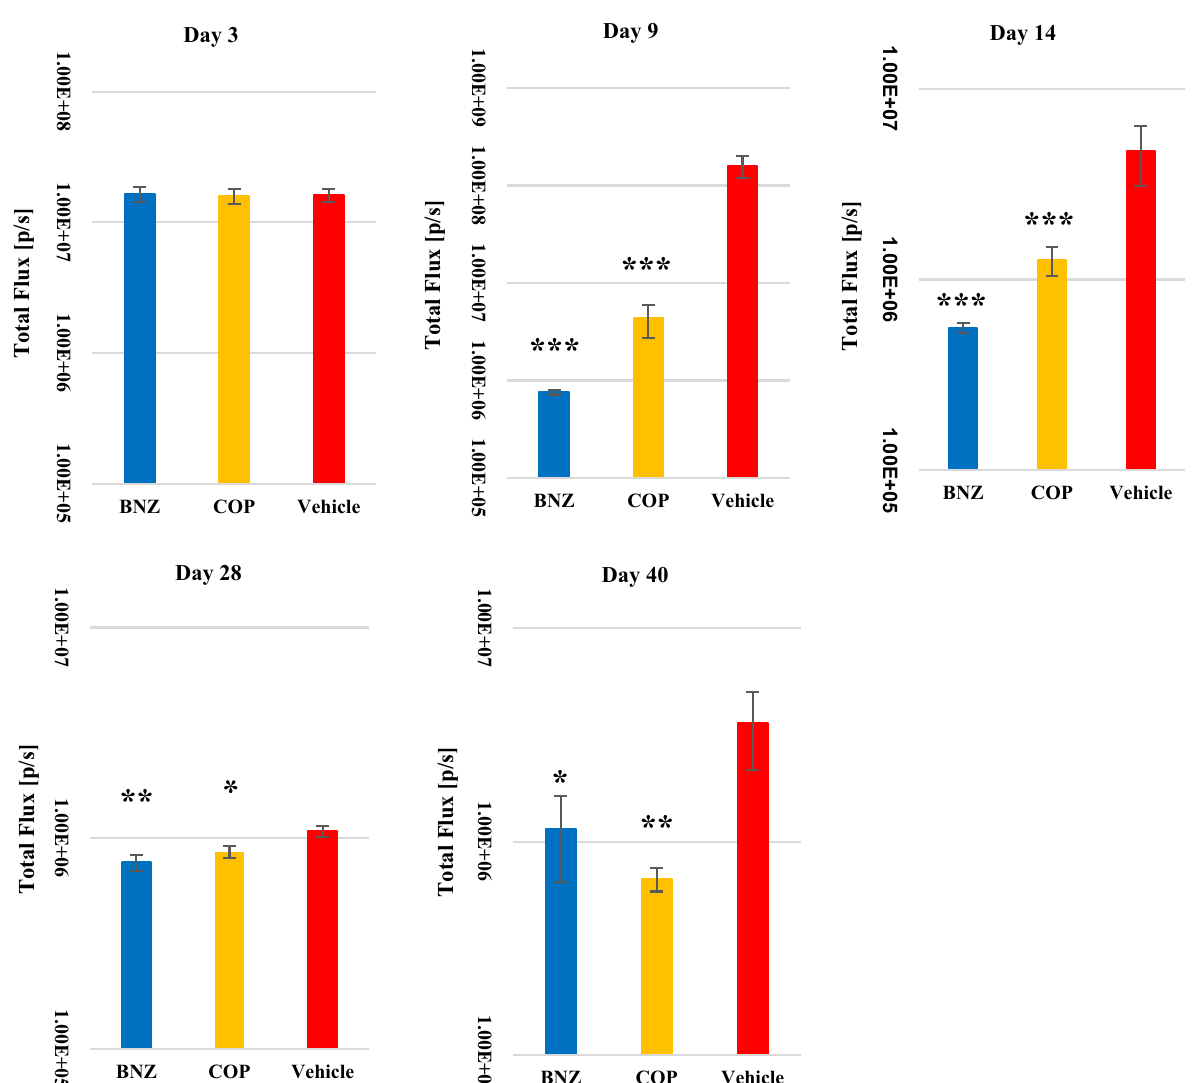
Fig. 5 Luminescence intensity at different timepoints in the mice model infected with 5 (COP) (30 mg/kg, 2 i.p.); positive control is benznidazole (BNZ) (100 mg/kg, 1 × imaging was obtained in an IVIS Lumina II system. Data are presented as mean and standard deviation in intensity of three experiments (* p < 0.05, ** p < 0.01, *** p < 0.005 when compared with vehicle). In this experiment, we excluded mice with luminescence intensity less than 1 pre-drug measurements (Day